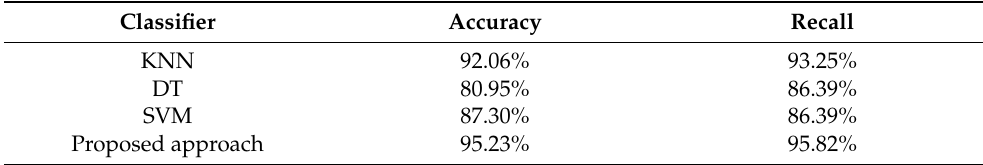
Table 7. Comparison of the proposed approach with other classifiers.